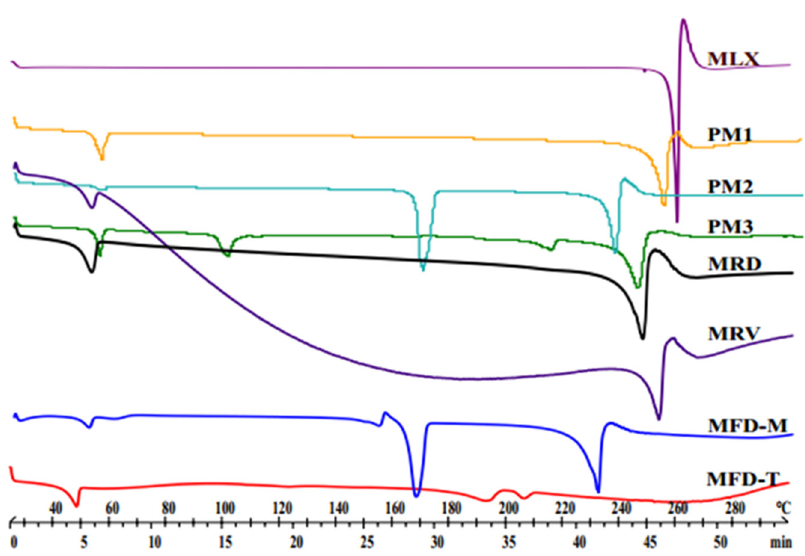
Figure 2. DSC thermograms of MLX-related samples of raw MLX, PM1 (MLX: F68, 5:1), PM2 (MLX: F68: M, 5:1:3), PM3 (MLX: F68: T, 5:1:3), and dried nanocrystals.